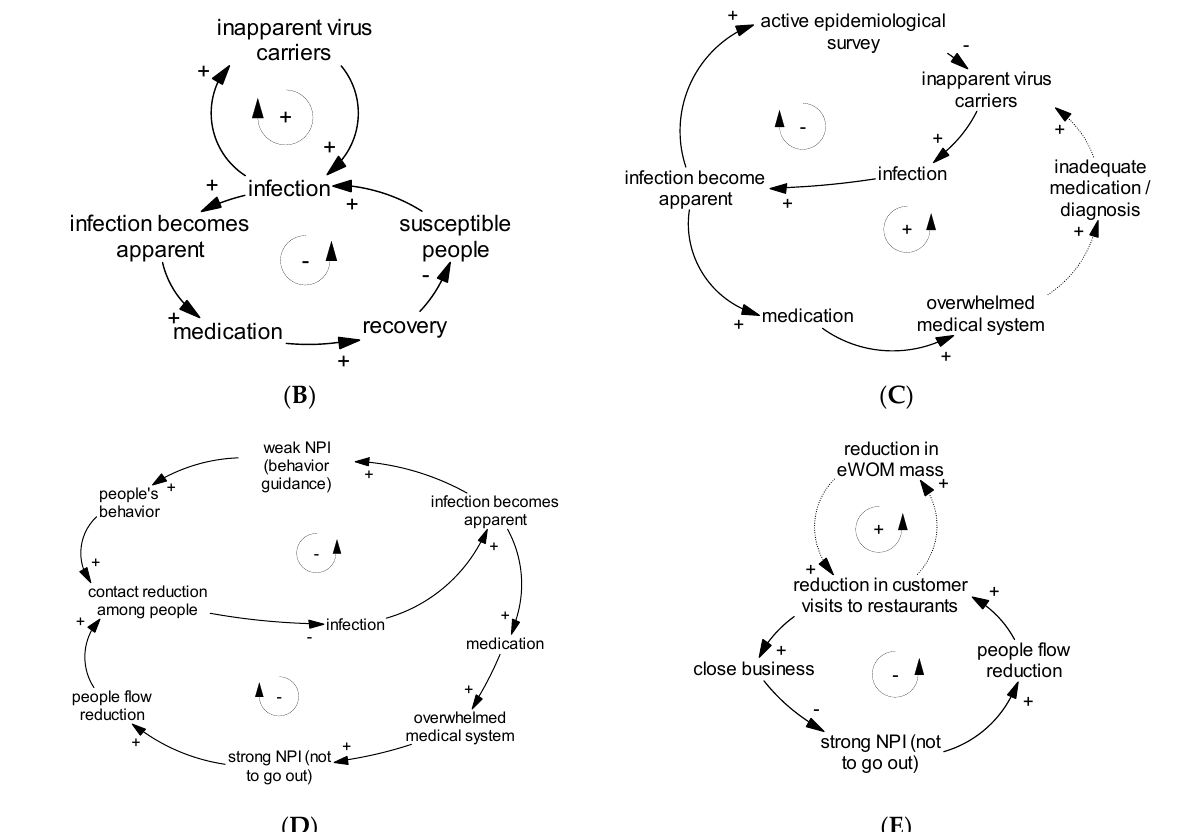
Figure 3. Causal loop diagram for COVID-19 transmission reflecting Japanese non-pharmaceutical interventions (NPIs). Solid arrows indicate relationships supported by theories or previous studies, while broken lines indicate hypothetical relationships, both reflecting the mind model in the system dynamics context. Restaurants were deemed representative businesses. Each panel shows ( A ) the whole picture, ( B ) reinforcing the infection spreading loop and balancing the herd immunity loop, ( C ) balancing the active epidemiological survey loop and reinforcing the medical collapse loop, ( D ) balancing the people’s behavior loop and strong NPI loop, and ( E ) reinforcing the electronic word-of-mouth (eWOM) loop and balancing the negative effects on strong NPI loop.